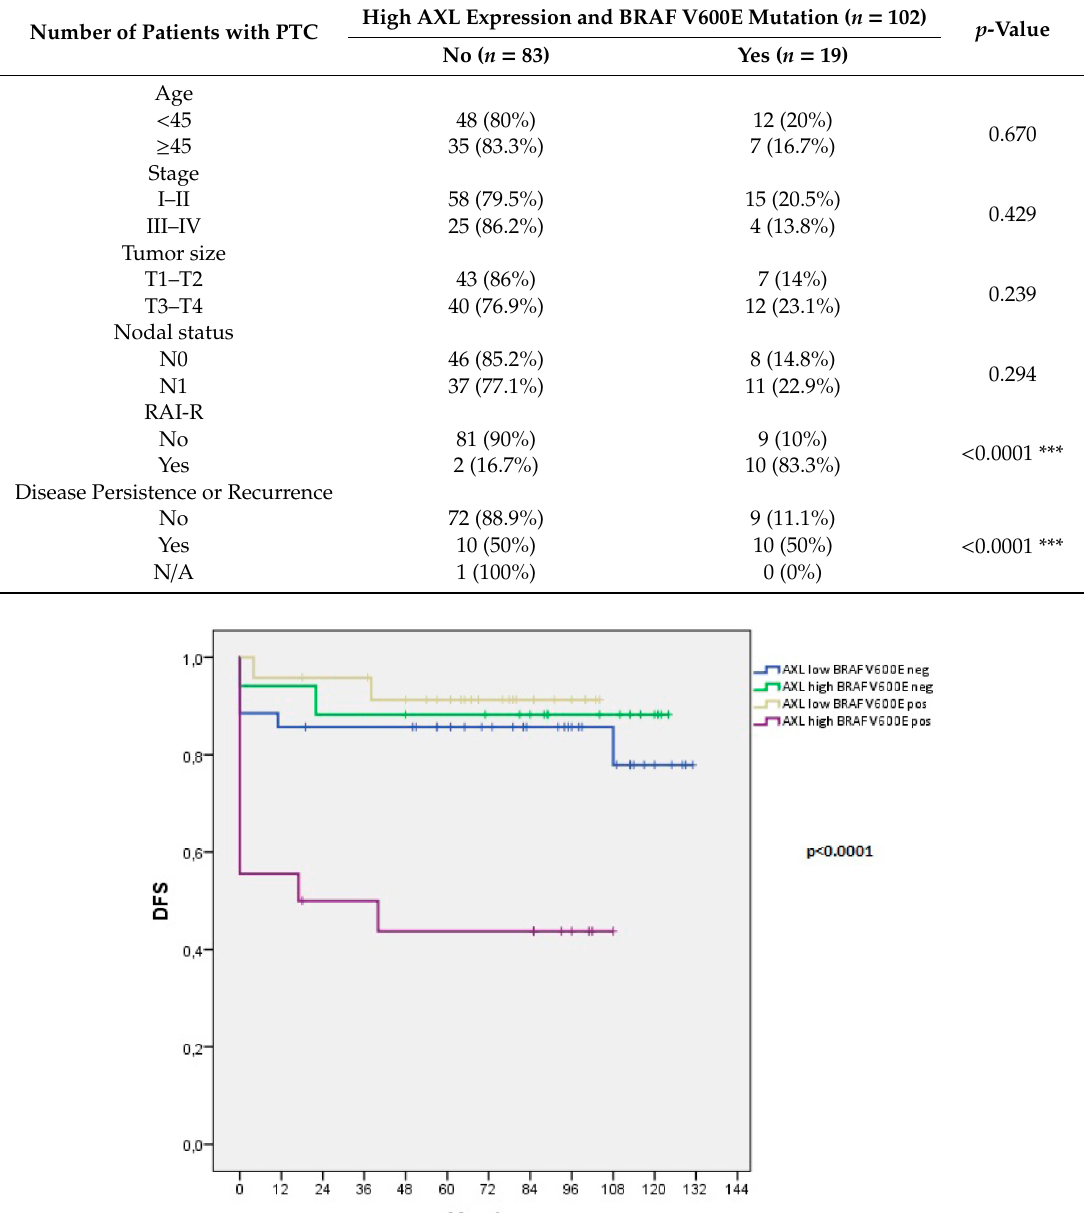
Figure 4. Kaplan-Meier estimation of Disease Free Survival (DFS) in thyroid cancer patients stratified for AXL expression and BRAF mutational status. Disease Free Survival curves of patients with papillary thyroid cancer stratified as: (i) AXL low + BRAF V600E negative, (ii) AXL low + BRAF V600E positive, (iii) AXL high + BRAF V600E negative, (iv) AXL high + BRAF V600E positive. Persisting patients